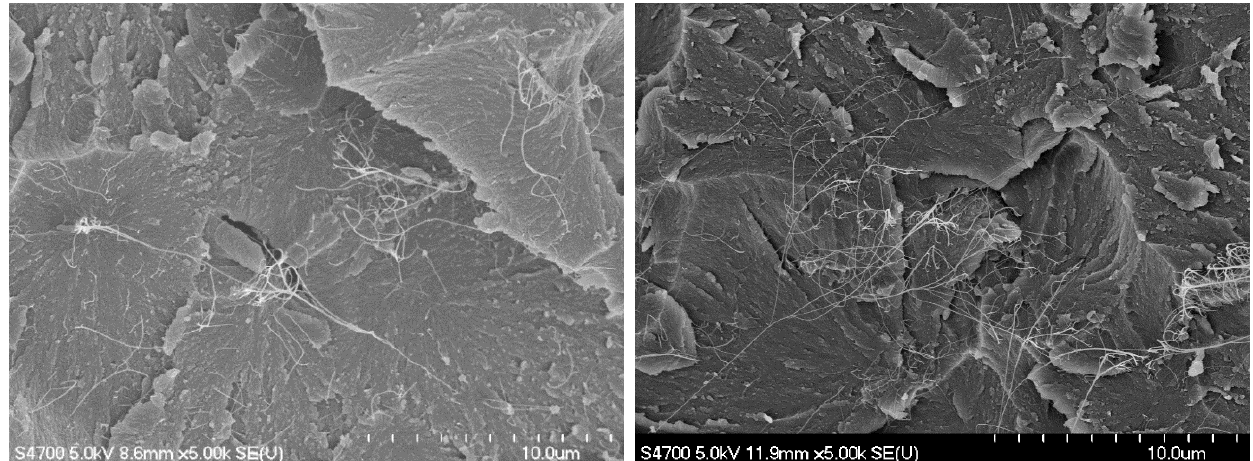
Figure 4. FE-SEM image ×5000 magnification of flexural fracture surface of 0.4 wt% as-received MIRALON ® pulp/epoxy ( left ) and 0.4 wt% MIRALON ® pulp acid treated (6 h in 10 M nitric at 120 °C)/epoxy ( right ).